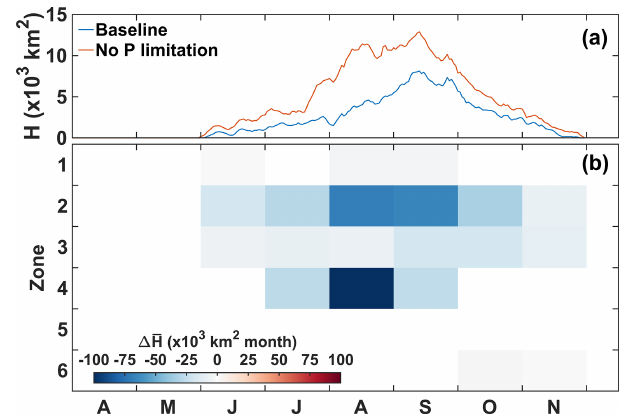
Figure 9. Averaged hypoxic area in the baseline (blue) and NoPlim (red) simulations (a) and difference in time-integrated hypoxic area for each zone (baseline – NoPlim) (b) . Both panels represent aver- aged values for